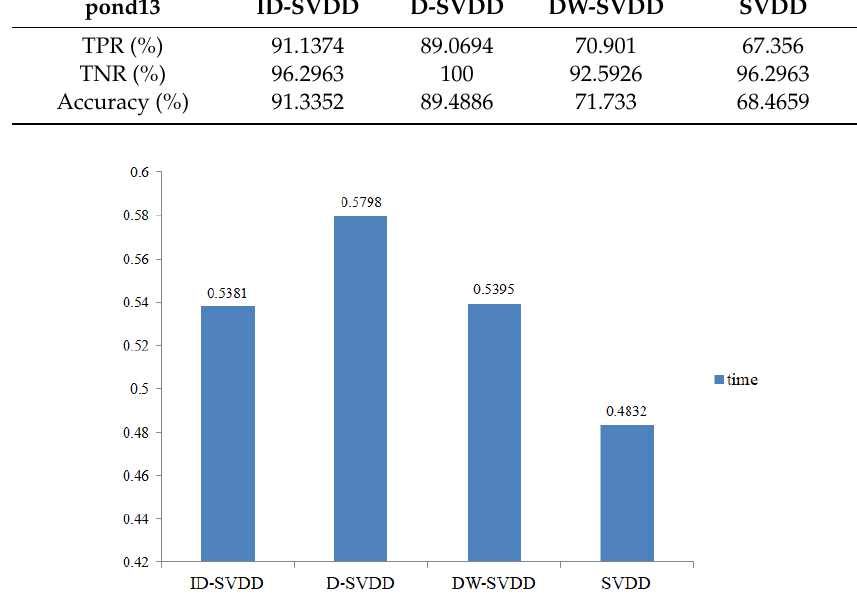
Figure 5. Outlier detection time of the water quality dataset with different algorithms.